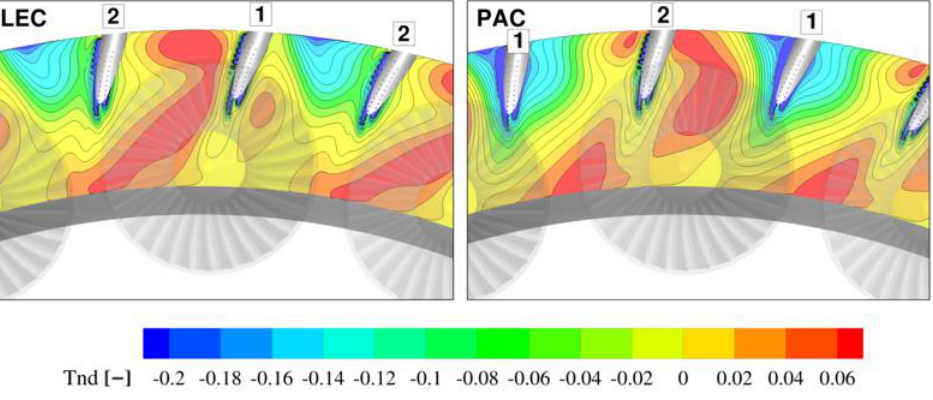
Figure 11. Non-dimensional temperature at P40.